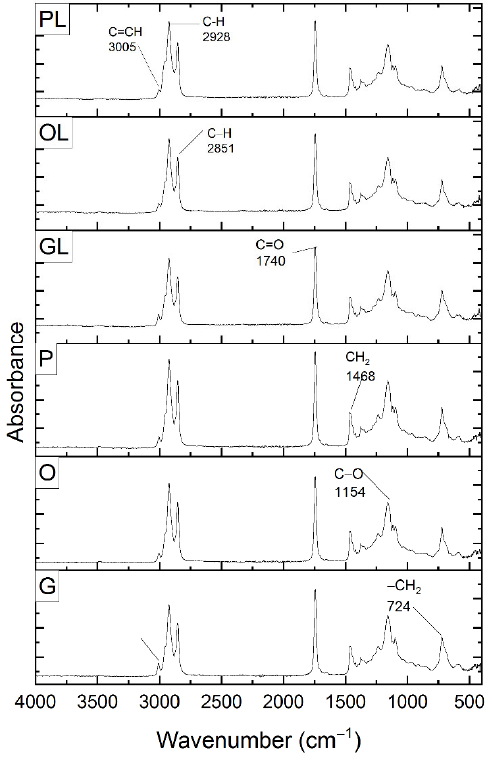
Figure 8. FTIR spectrum of native oils (P, O, G) and oils with lycopene (PL, OL, GL).